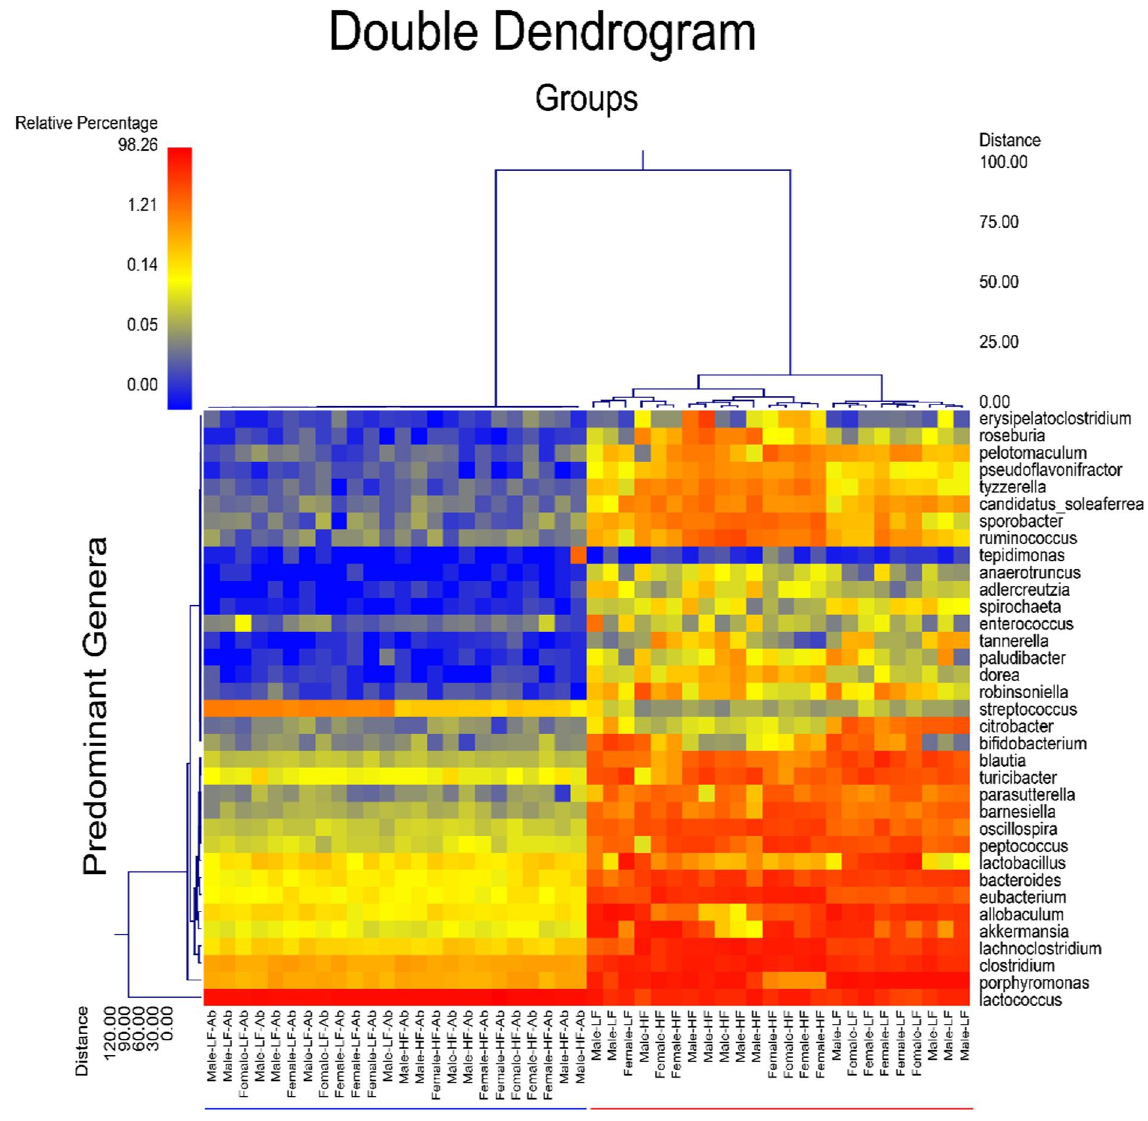
Fig 4. Dual hierarchical dendrogram (n = 6/group). To provide a visual overview combined with analysis, a dual hierarchal dendrogram was used to display the data for the predominant genera with clustering related to the different groups. Samples with more similar microbial populations were mathematically clustered closer together. The genera (consortium) were used for clustering. The samples with more similar consortium of genera cluster closer together with the length of connecting lines (top of heatmap) related to the similarity, shorter lines between two samples indicate closely-matched microbial consortium. The heatmap represents the relative percentages of each genus. The predominant genera are represented along the right Y-axis. The legend for the heatmap is provided in the upper left corner. The heat map and clustering reveals a significant effect of antibiotic